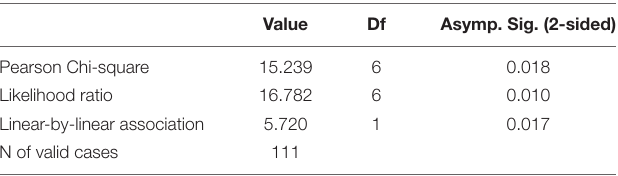
TABLE 3 | Results of Chi-Square